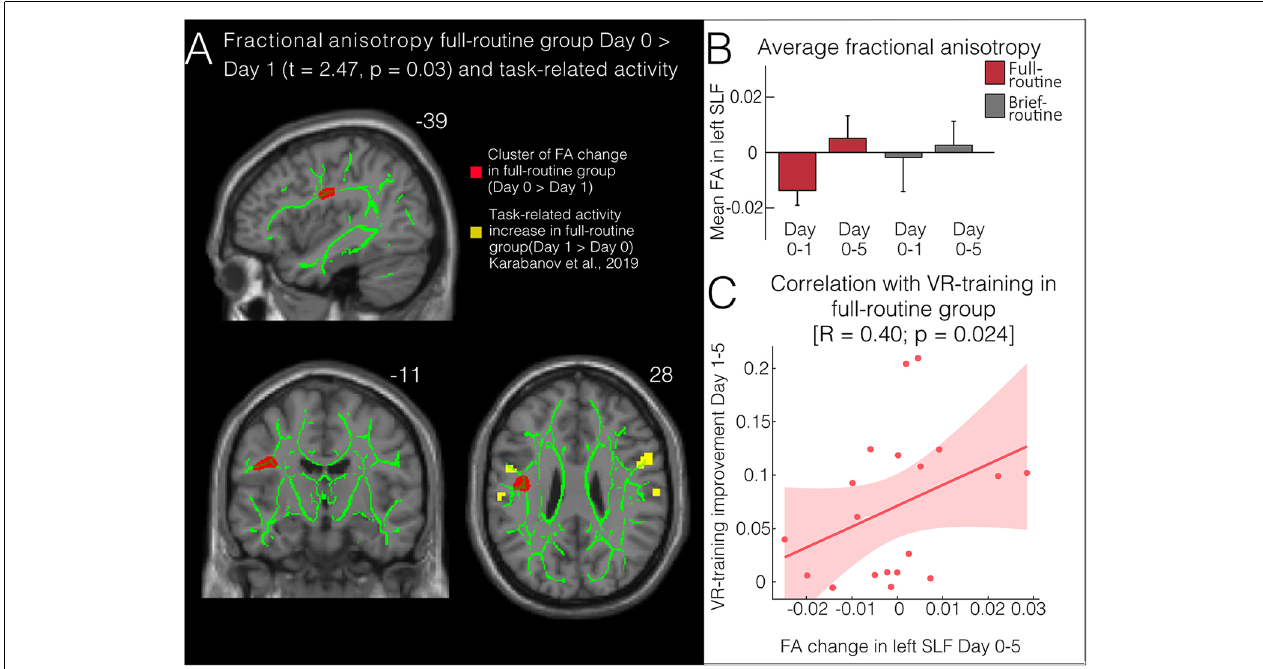
FIGURE 2 | Structural changes following bimanual skill learning. (A) Fractional anisotropy (FA) decreases in full-routine subjects (but not brief-routine subjects) after one training session on the VR-simulator in a cluster (red) in the left superior longitudinal fasciculus (SLF) (visualized using tbss_fill). Significant clusters of change in task-related fMRI (yellow; Karabanov et al., 2019) lie very close to the clusters of structural change. Both superimposed with the TBSS skeleton (green). (B) Average FA on Day 1 and Day 5 compared to baseline (Day 0). There is a significant change in FA from Day 0 to Day 1 in the full-routine group. (C) Improvement of VR-endoscopic skill performance from the first to the last day of training correlates with changes in FA in the left SLF from the first to the last day of